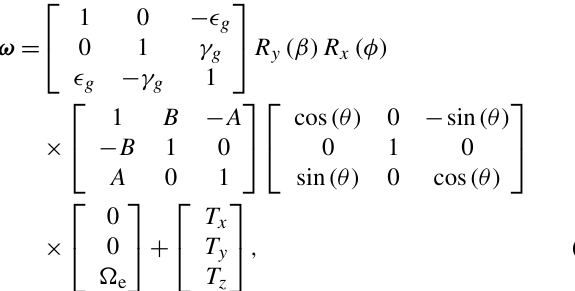
Figure 1. GyroDIF